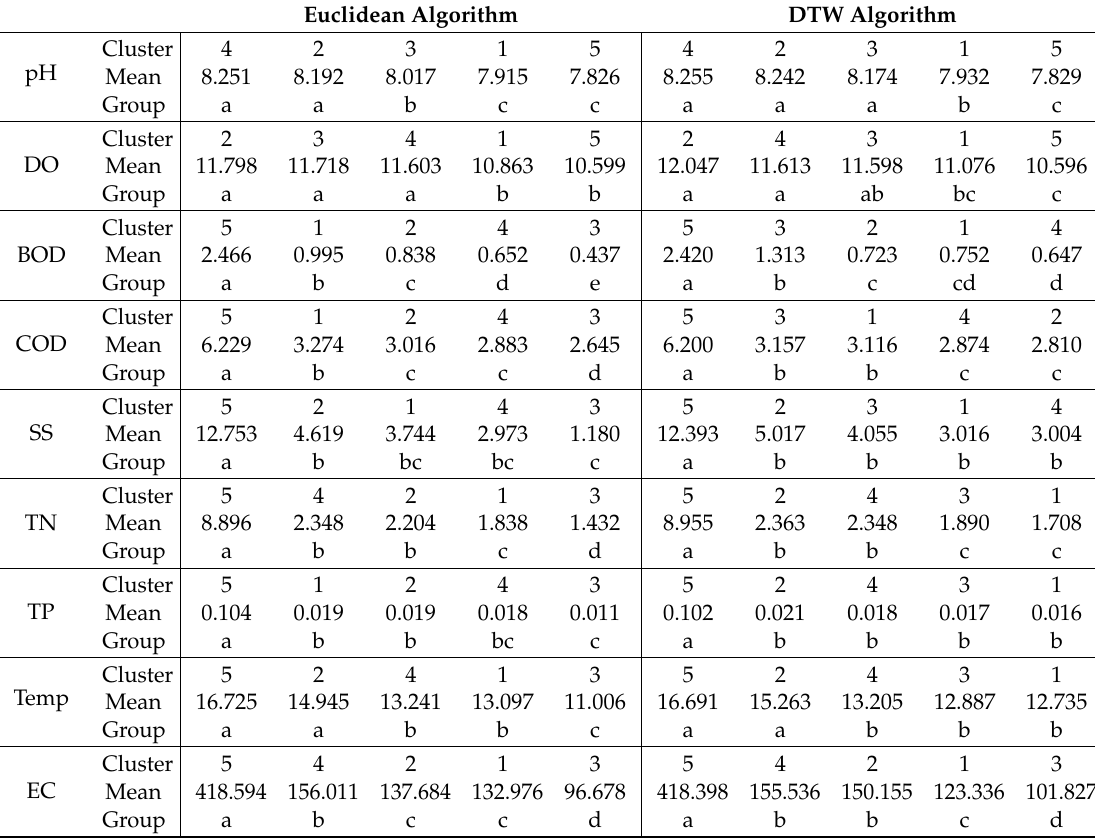
Table 5. Post hoc test results for cluster analysis using the Euclidean and Dynamic Time Warping (DTW)